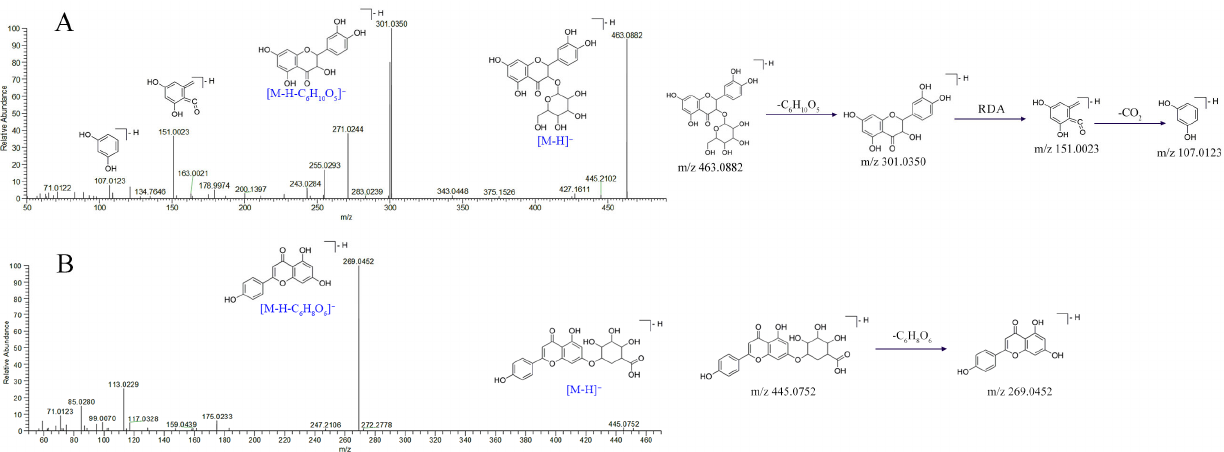
Figure 2. Characteristic of MS/MS spectra and possible fragmentation pathways of hyperoside ( A ) and apigenin ‐ 7 ‐ O ‐ glu ‐ curonide ( B